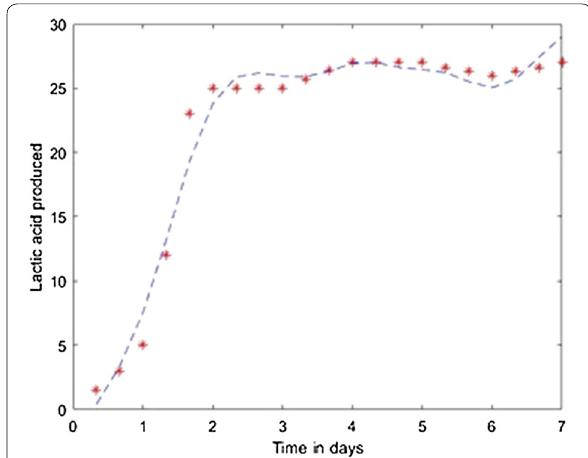
Fig. 16 Simulation of the model on 40% glycerol 60% LGJ for Polak– Ribiere Conjugate Gradient